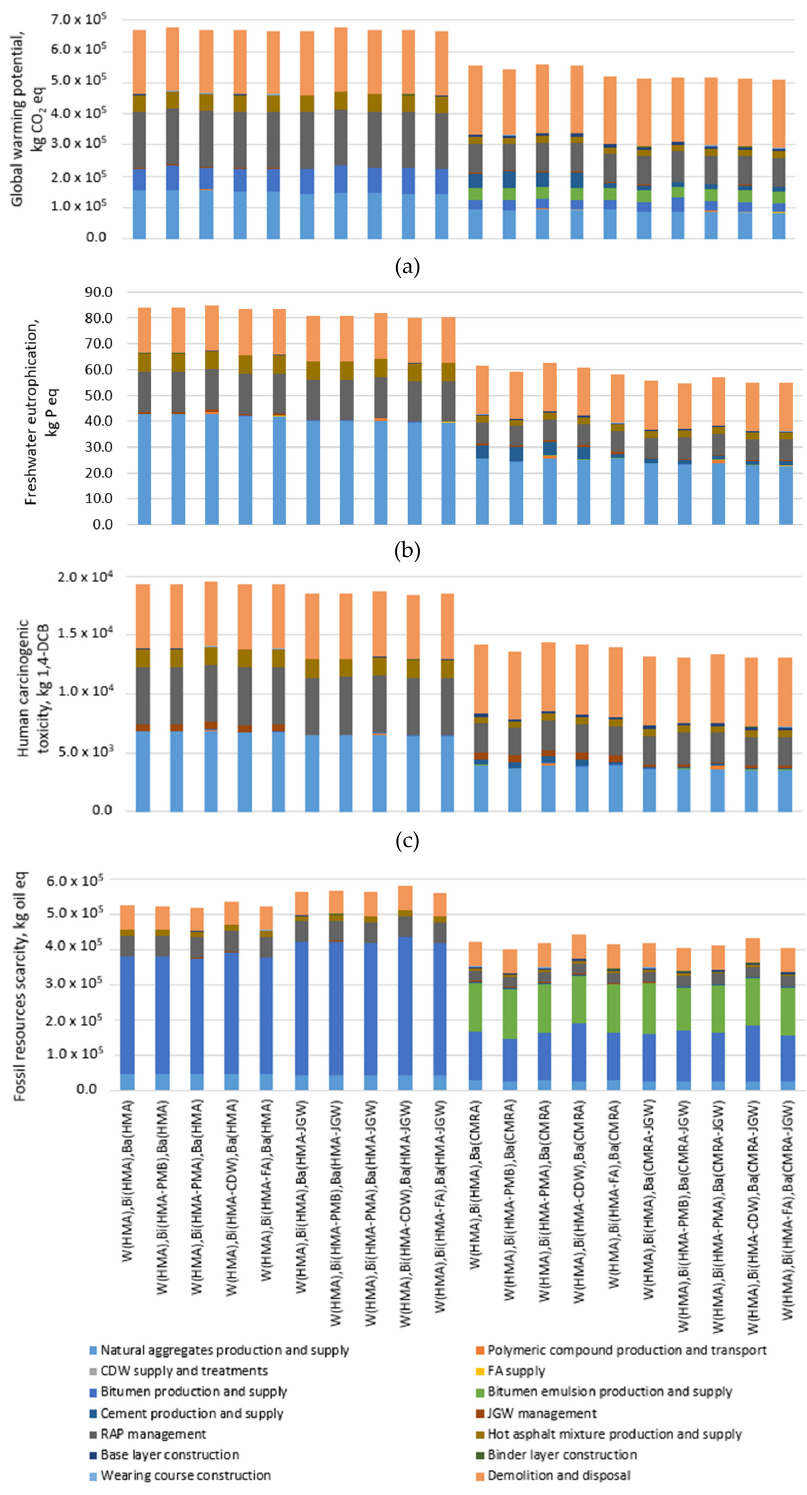
Figure 4. Process contribution for each pavement configuration to ( a ) global warming potential, ( b ) freshwater eutrophication, ( c ) human carcinogenic toxicity, and ( d ) fossil resources scarcity.